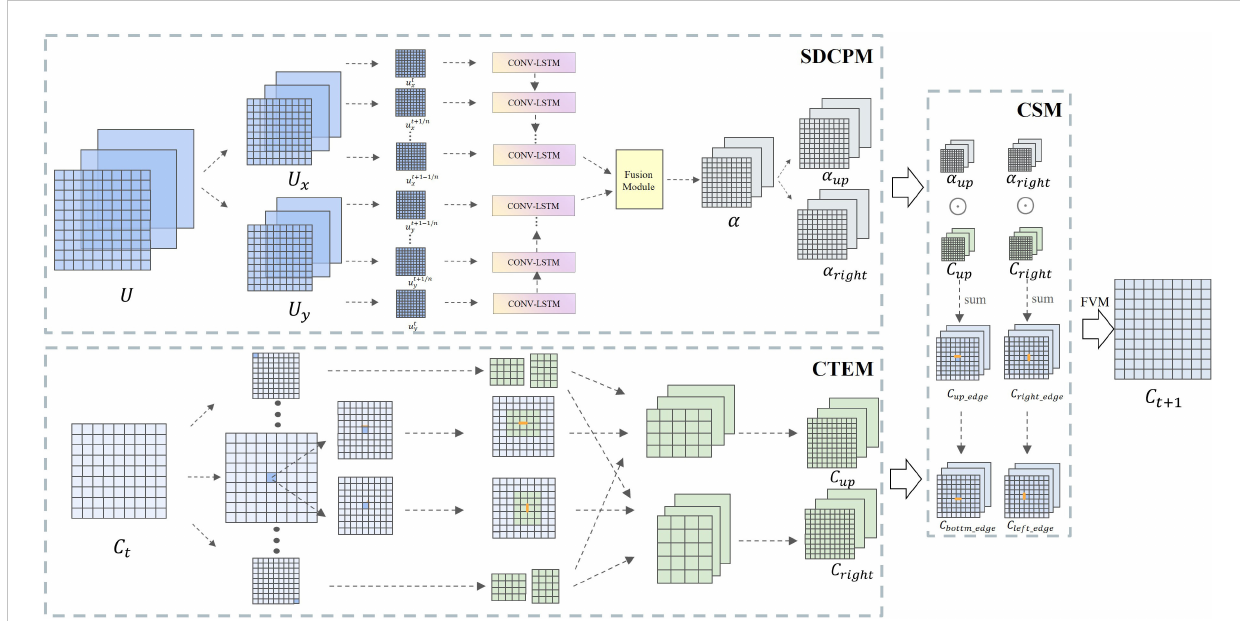
FIGURE 2 The framework of our approach. This framework is utilized for the solution of the passive scalar advection equation in a two-dimensional unsteady fl ow. It contains three modules: SDCPM, CTEM and CSM. SDCPM: This module receives multiple velocity fi eld information at different times, extracts spatiotemporal features in two spatial dimensions (along the x-axis and y-axis), and fi nally fuses them in the spatial dimension to predict the spatial discretization coef fi cient of each grid point; CTEM: This module extracts the surrounding point concentration template of each grid point corresponding to the size of its spatial discretization coef fi cient template; CSM: This module calculates numerical solutions to the advection equations based on the fi nite volume